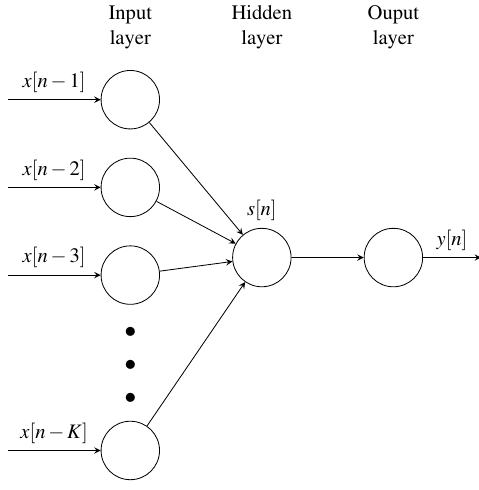
Figure 1. Single-layered TDNN pipeline. The network sequentially predicts the n -th sample in y [ n ] based on K delayed samples of x [ n ] . Please note that K directly reveals the number of units (TDNN